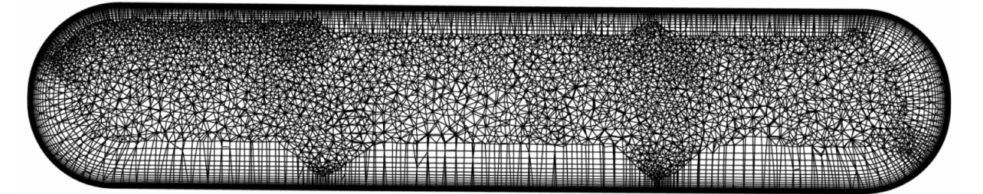
Figure 7. Draft tube fine mesh upstream pier nose.